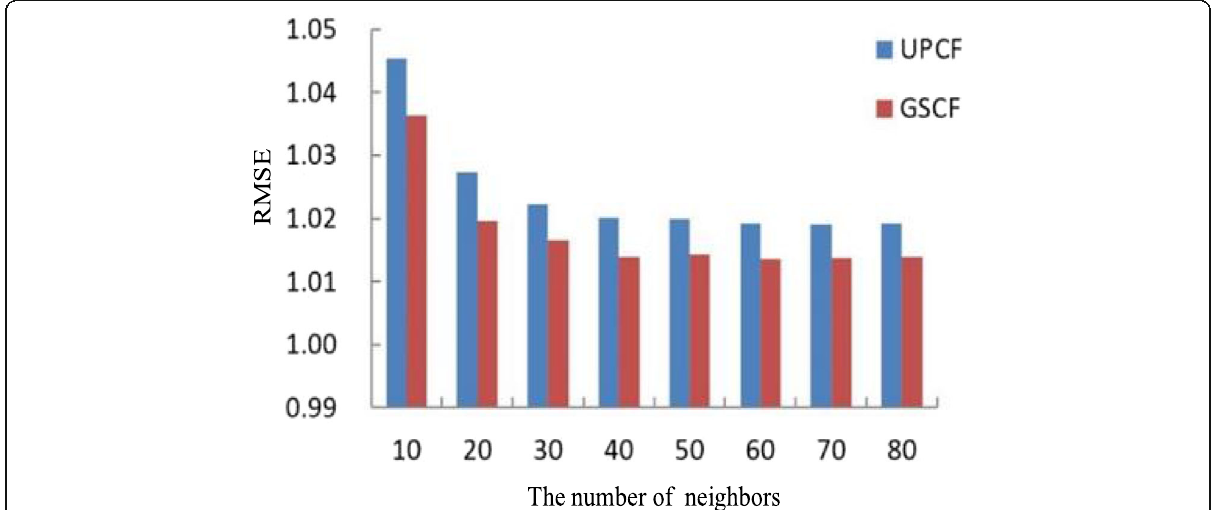
Fig. 9 Comparison of RMSE values of two improved algorithms in a data set of train1. With the near neighbor number as the variable, the RMSE values of the two kinds of recommendation algorithms decrease first and then increase, and finally tend to be gentle. When the near neighbor number reaches about 40, the RMSE value of the two algorithms is the smallest, that is, the algorithm has the least error and the highest precision. In the case of the same number of near neighbors, the RMSE value of the algorithm UPCF is lower than that of the algorithm GSCF, that is, the error is